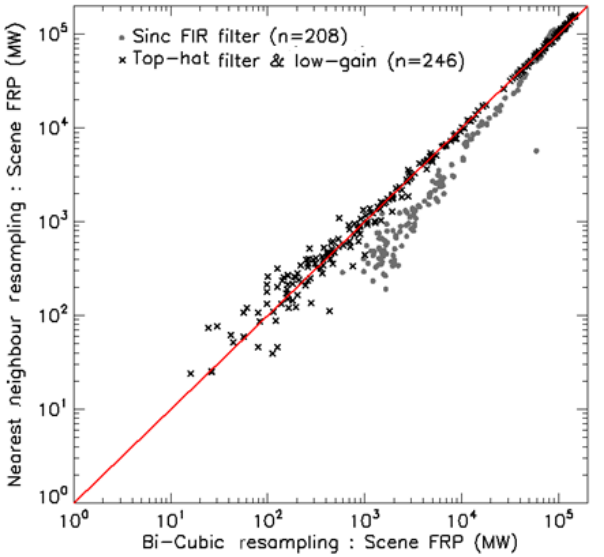
Figure 15. Frequency–magnitude distributions constructed from coincident active fire pixels detected by SEVIRI, H ( • ) and MODIS, F ( (cid:3) ) over the African continent between May 2008 and May 2009. The lower breakpoint of the SEVIRI distribution, H L , coincides with the decline in SEVIRI’s active fire detection perfor- mance as the thermal radiance emitted from small and/or lower in- tensity fires cannot be reliably distinguished from that of the back- ground window, so many remain undetected. The upper breakpoint, H L , coincides with the onset of IR3.9 detector saturation. The Level 3 FRP-GRID product aims to account for the FRP that SEVIRI fails to detect as a result of these sensor artefacts as well as by that due to cloud